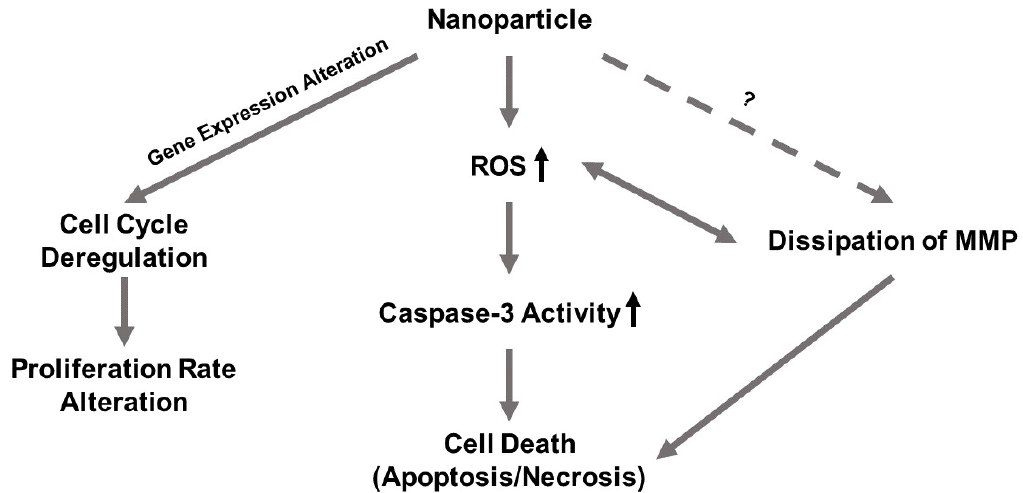
Figure 13. Cell viability is a function of cell death and suppression of proliferation.